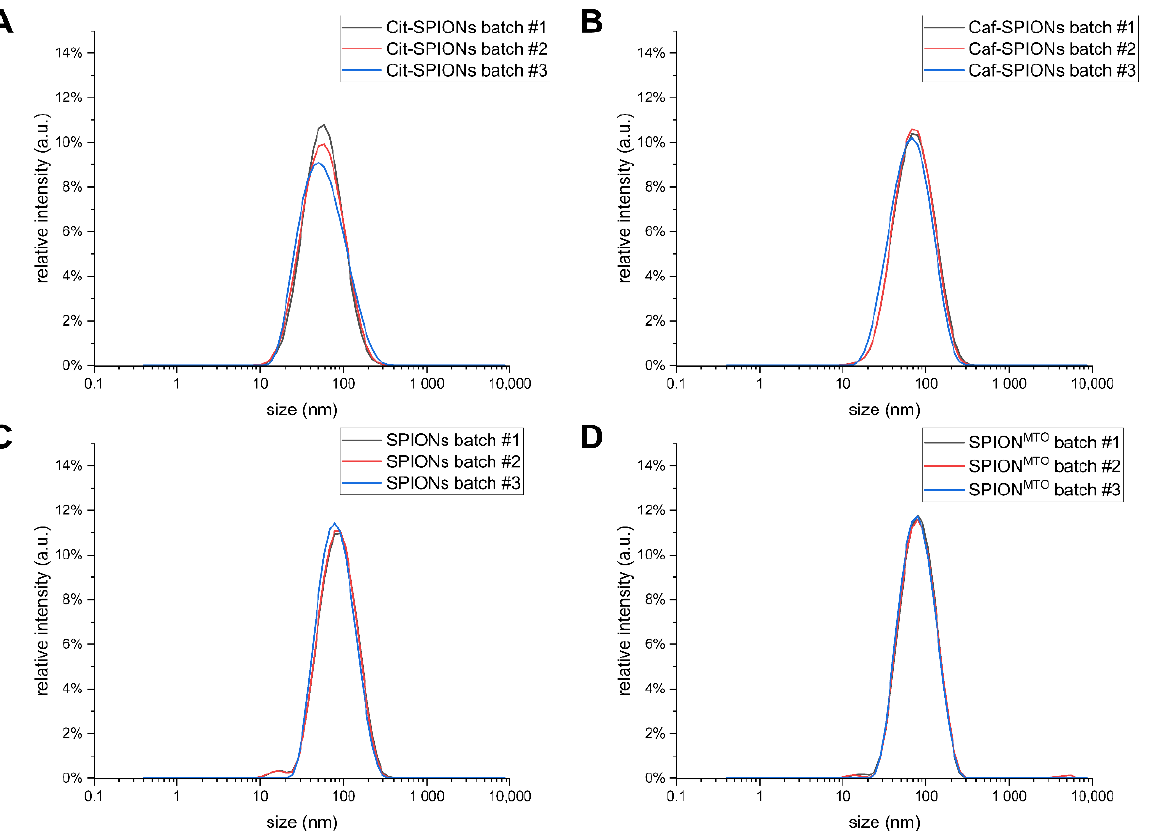
Figure A1. Size distribution of ( A ) Cit-SPIONs, ( B ) Caf-SPIONs, ( C ) SPIONs and ( D ) SPION MTO .